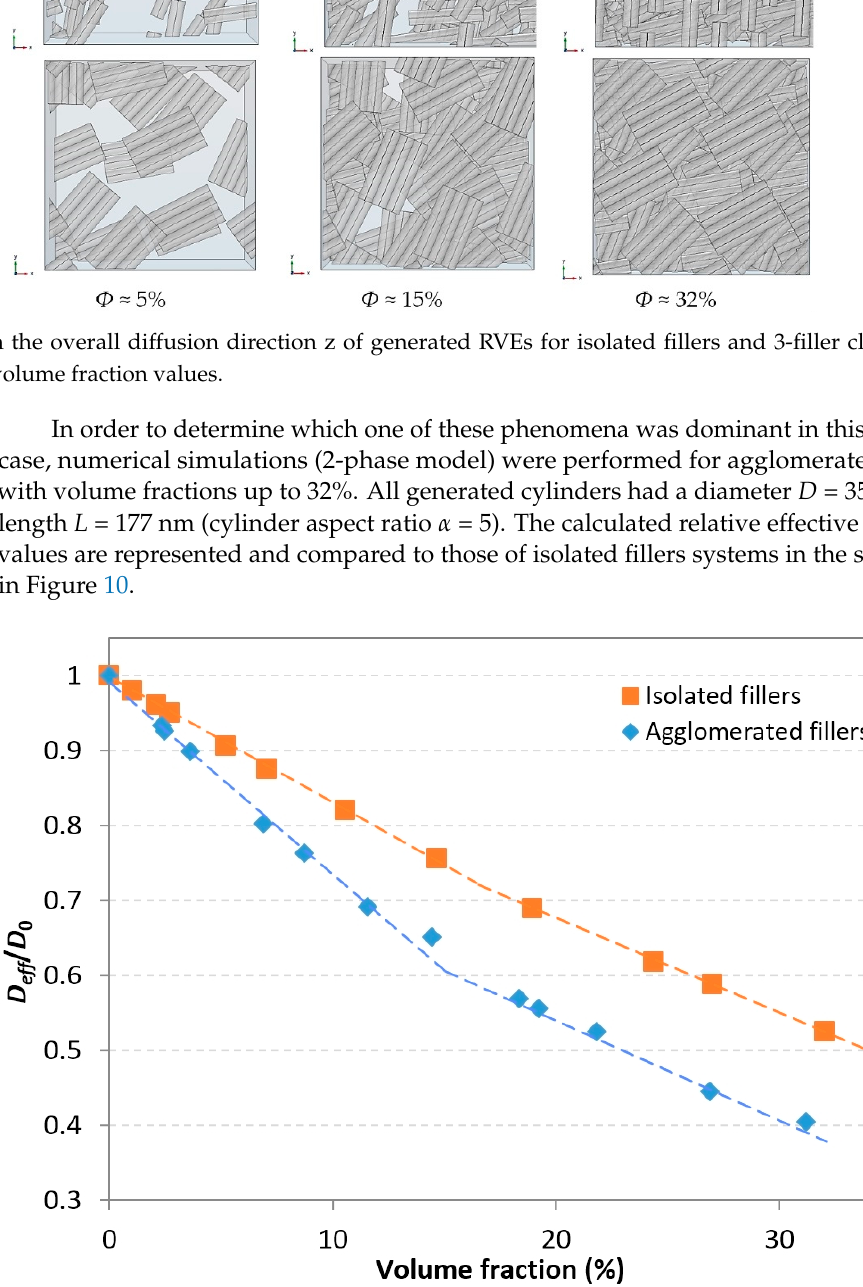
Figure 10. Effects of filler agglomeration (3-filler clusters) on the relative effective diffusivity (monodisperse fillers, α = 5). The dashed lines are guides.